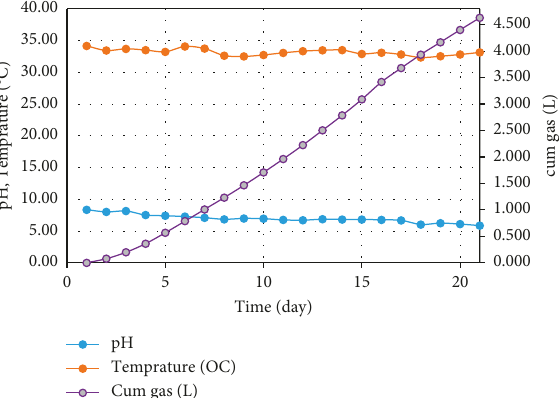
Figure 5: Relation between temperature, pH, and amount of gas produced at a 3:1 ratio (WW: